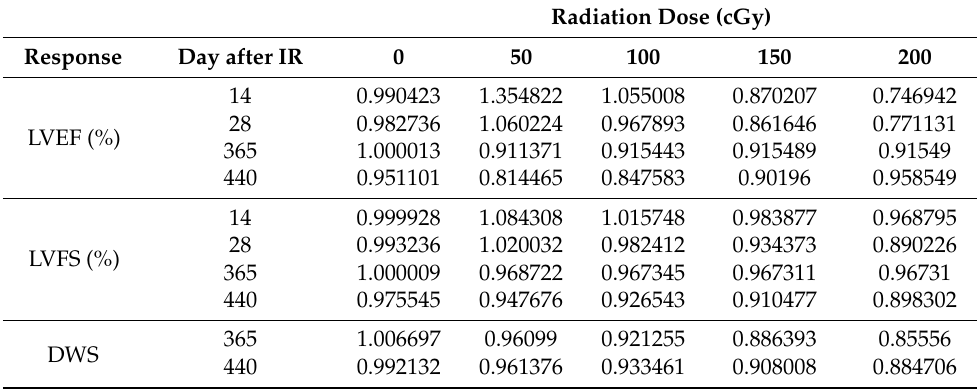
Table 2. RER values at the measured gamma and simGCRsim dose